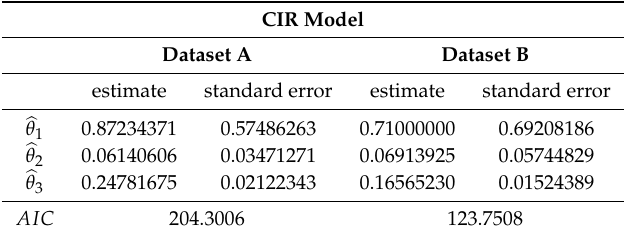
Table 3. ML estimates of Model (7) for Dataset A (on the left) and for Dataset B (on the right). Last row shows the AIC.